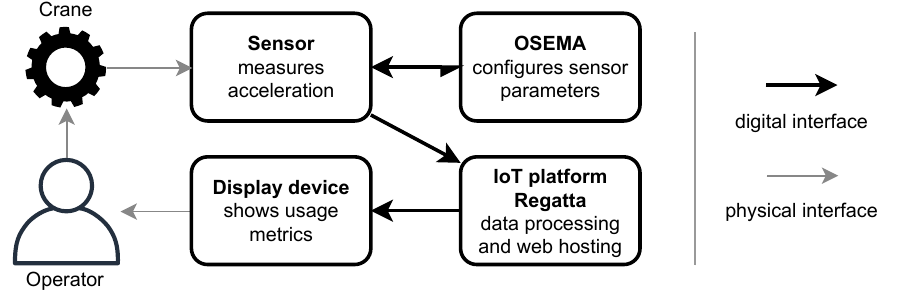
Figure 7. Components of the usage roughness indicator application.